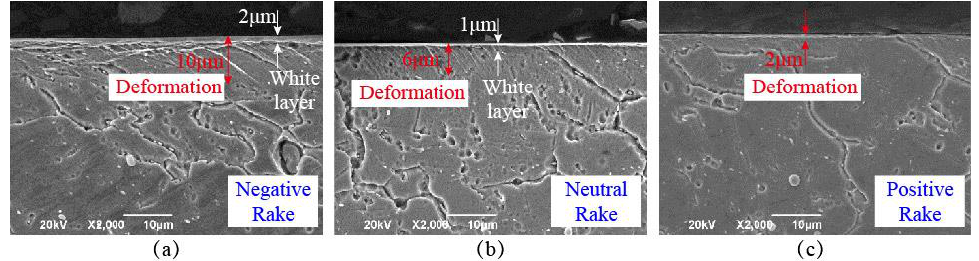
Figure 10. SEM images revealing the subsurface deformation for workpiece machined with different rake angle tools.